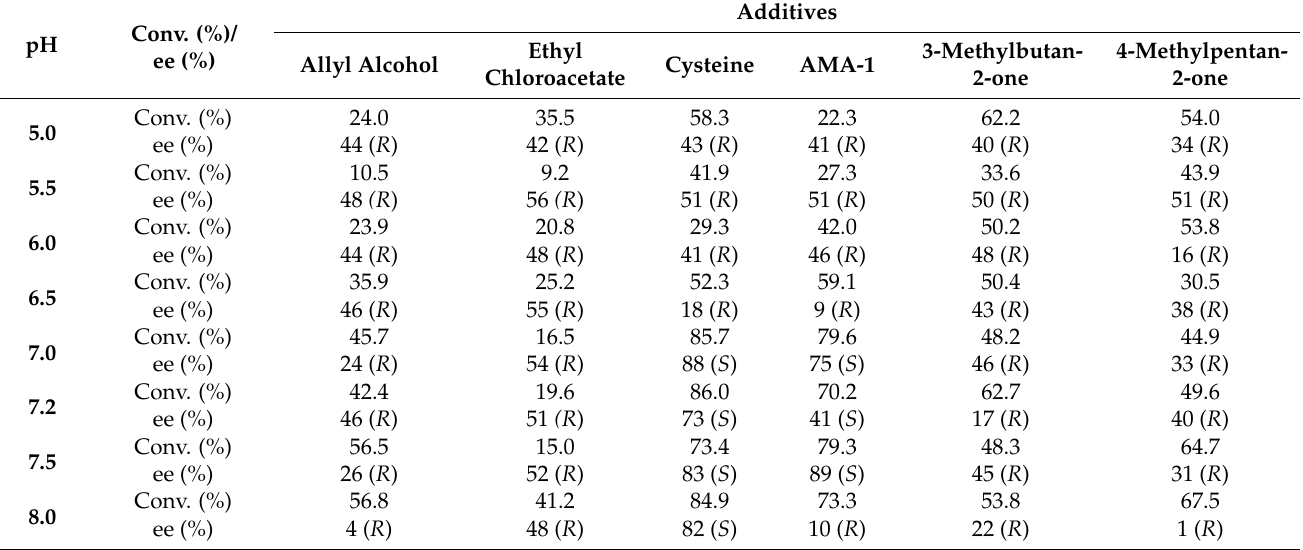
Table 4. Microbial Bioreduction of 1 in Phosphate Buffer at Different pH Values with